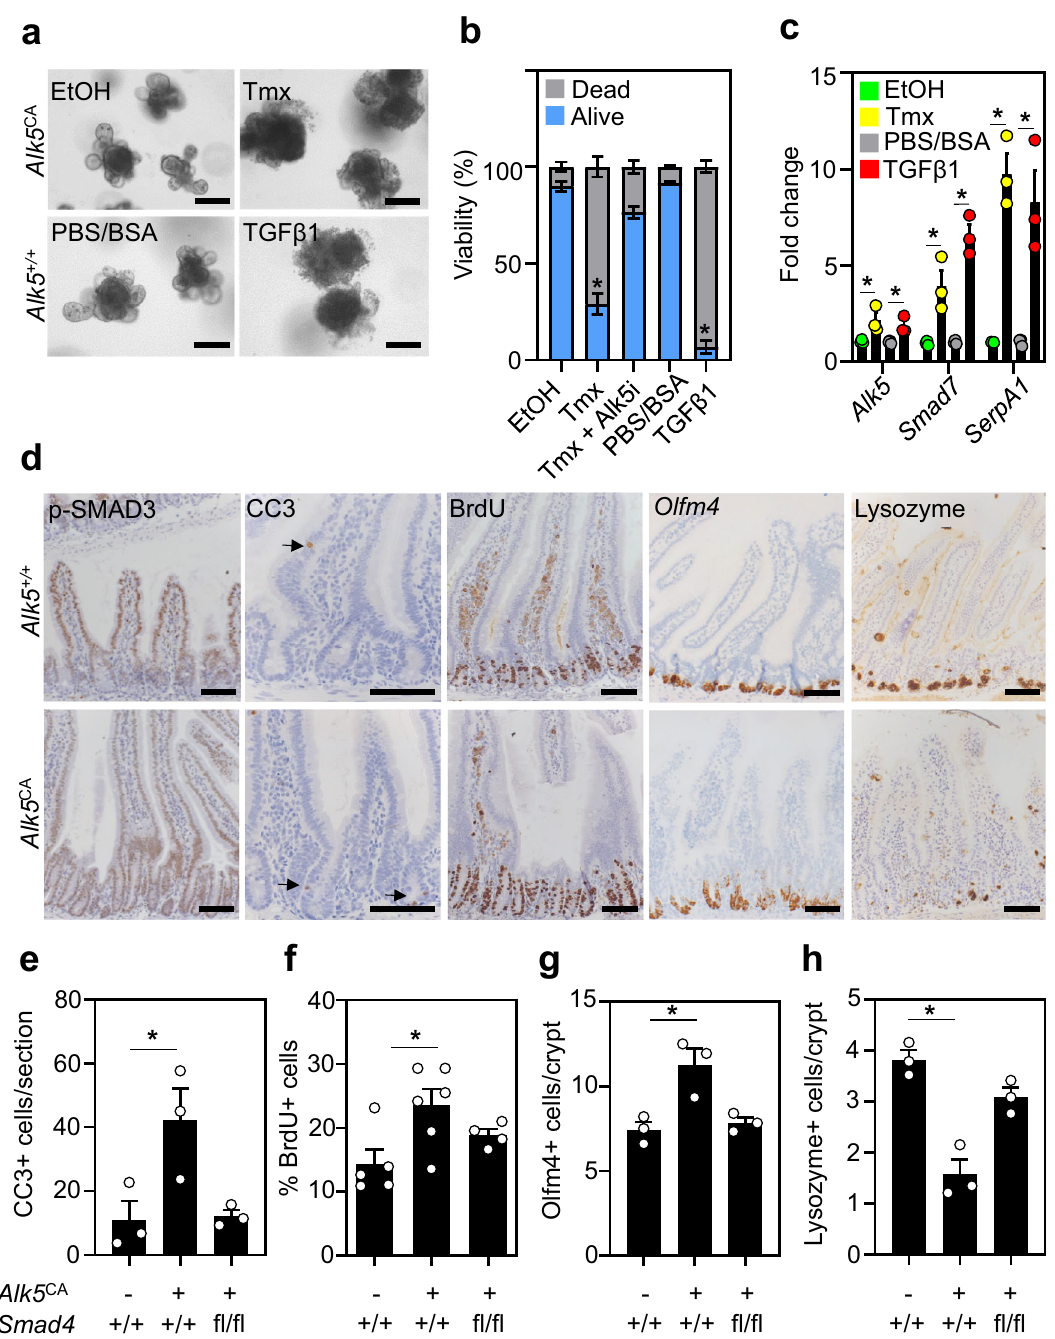
Fig.2|Epithelialcell-intrinsicactivationofTGF β